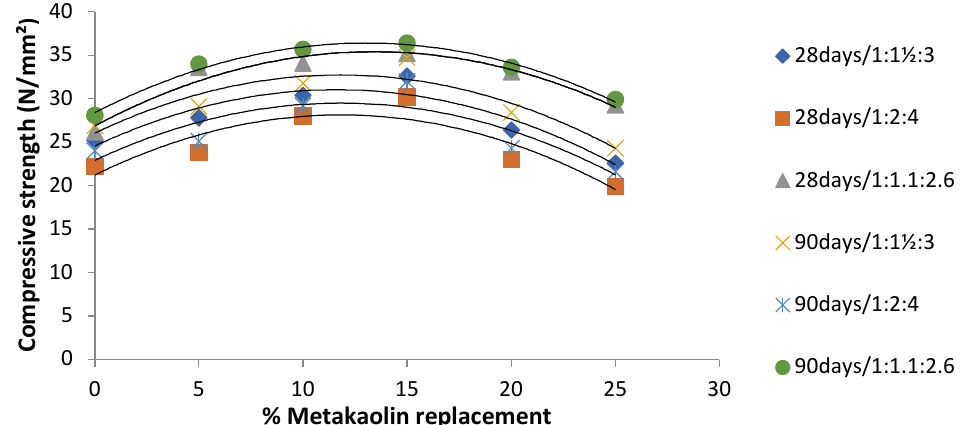
Figure 9. Compressive strength of cement-metakaolin concrete.